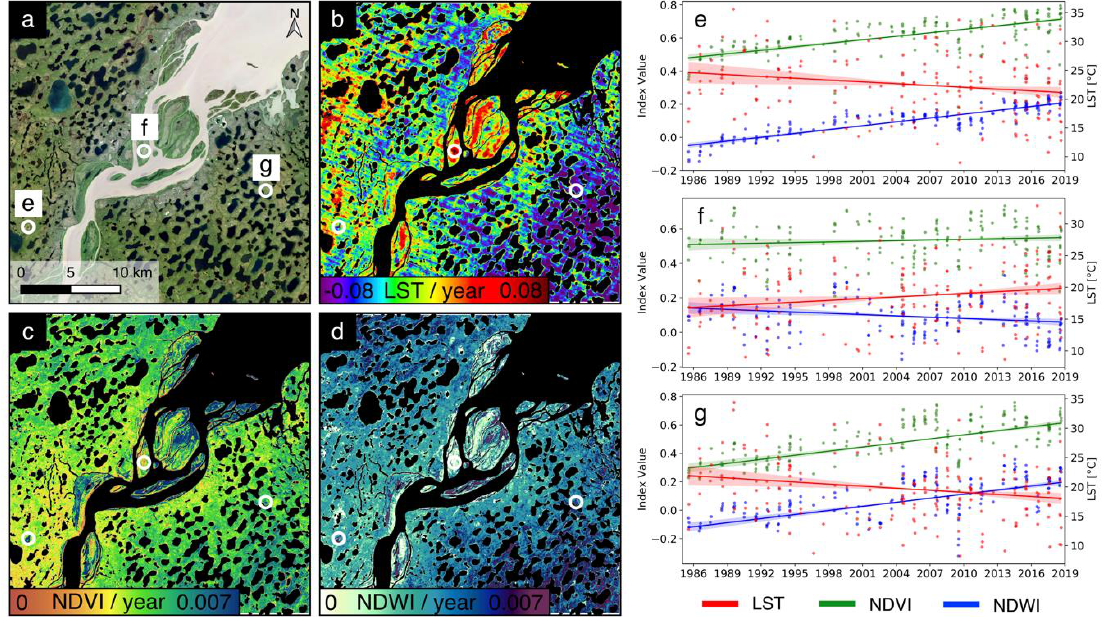
Figure 8. Local temporal dynamics for the “East Channel” subregion: true color RGB Landsat image ( a ), Theil-Sen slopes of the LST ( b ), NDVI ( c ), and NDWI ( d ), as well as Theil-Sen regression lines of selected locations ( e – g ). Each plot location represents the spatial average of 90 × 90 m. The trend lines are complemented by the lower and upper limit of the 95% confidence interval of the slope coefficient.